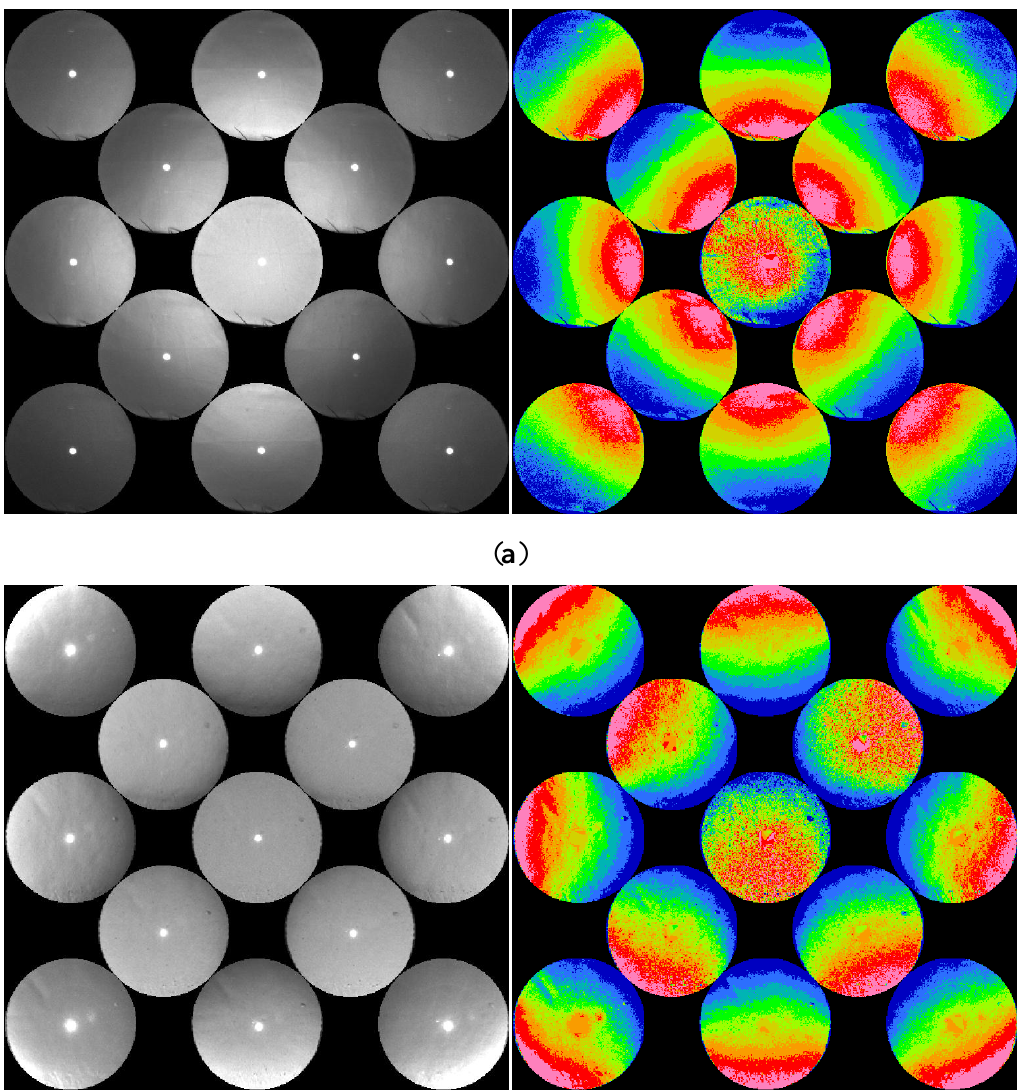
Figure 5. ( a ) Image acquired from the left eye of a 47 year-old Caucasian female seeking presbyopia correction. The center reflex image in the 13-image map is the coaxial image. The eye is 20/20 with no correction (plano). The gray-scaled images show no optical defects. When viewing a series of reflex images along an arbitrary meridian, the brightness appearance emerges ―against the motion‖ that is similar to the spot retinoscope observation. ( b ) Image acquired from an eye with refractive error and BCVA are −6.25DS + 0.75DCX075 and 20/25, respectively. The color map on the right demonstrates a well-defined symmetric pattern with outward brighter features, and this resembles ―with the motion‖ behavior of the spot retinoscope of myopia. ( c ) Image acquired from the same eye in (b) while the tear film breakup occurred. Emerging from the wobbling, wavy background is the same color map showing that the noise from high spatial frequency does not affect the low-order aberration